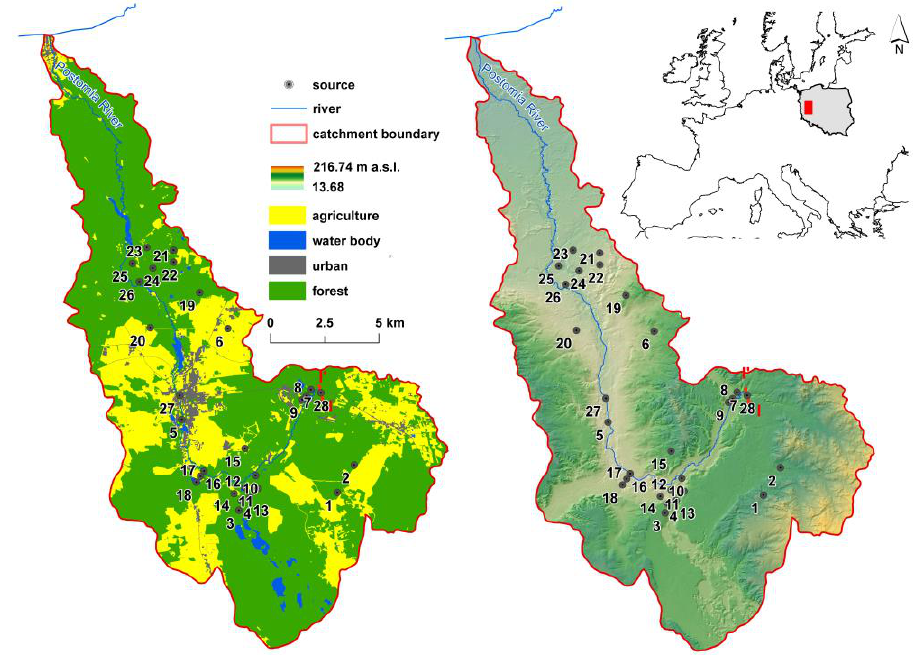
Figure 1. Study area with sampling point locations.